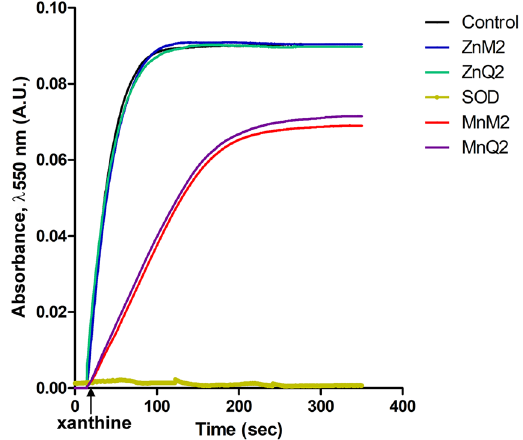
Figure 5. Kinetic of ⋅− O decomposition by MnQ2 and MnM2 assayed spectrophotometrically ( λ 550 nm) by 2 inhibition of cytochrome c reduction. In the control experiment (black line), xanthine was converted to uric acid in about 150 s (max. absorbance: 0.09; v max : 0.0021 arbitrary units, AU, s − 1 ). The cytochrome c reduction kinetic changed substantially in the presence of 50 μ M MnM2 (red line) (max. absorbance: 0.069; v max : 0.000457 AU s − 1 ) or 50 μ M MnQ2 (purple line) (max absorbance: 0.072; v max : 0.000460 AU s − 1 ), with a substantially similar catalytic efficiency of MnQ2 and MnM2. ZnM2 (blue line) and ZnQ2 (green line), in which the functional Mn II was replaced with redox-inert Zn II , did not induce any significant differences in respect to the